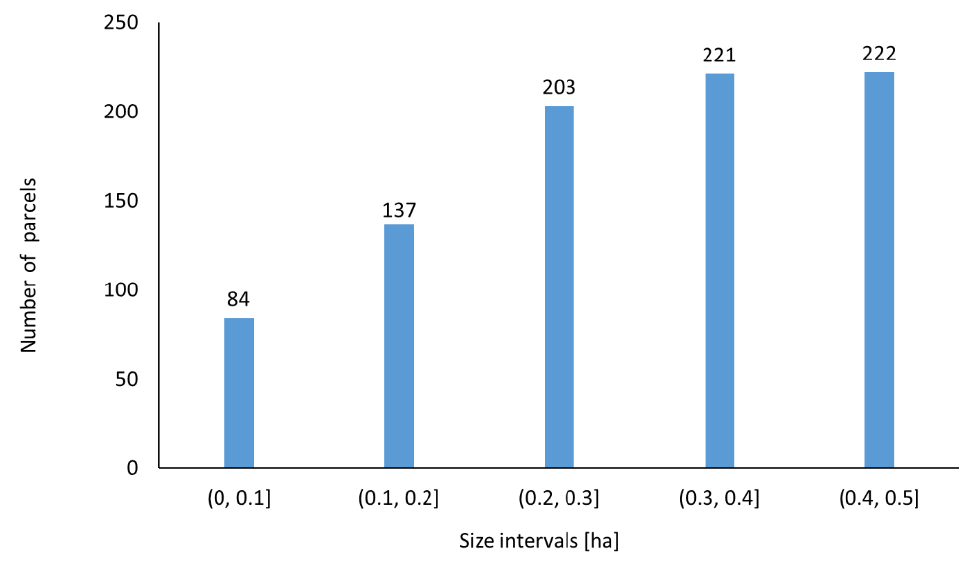
Figure 3. Distribution of parcels in a specific size category.